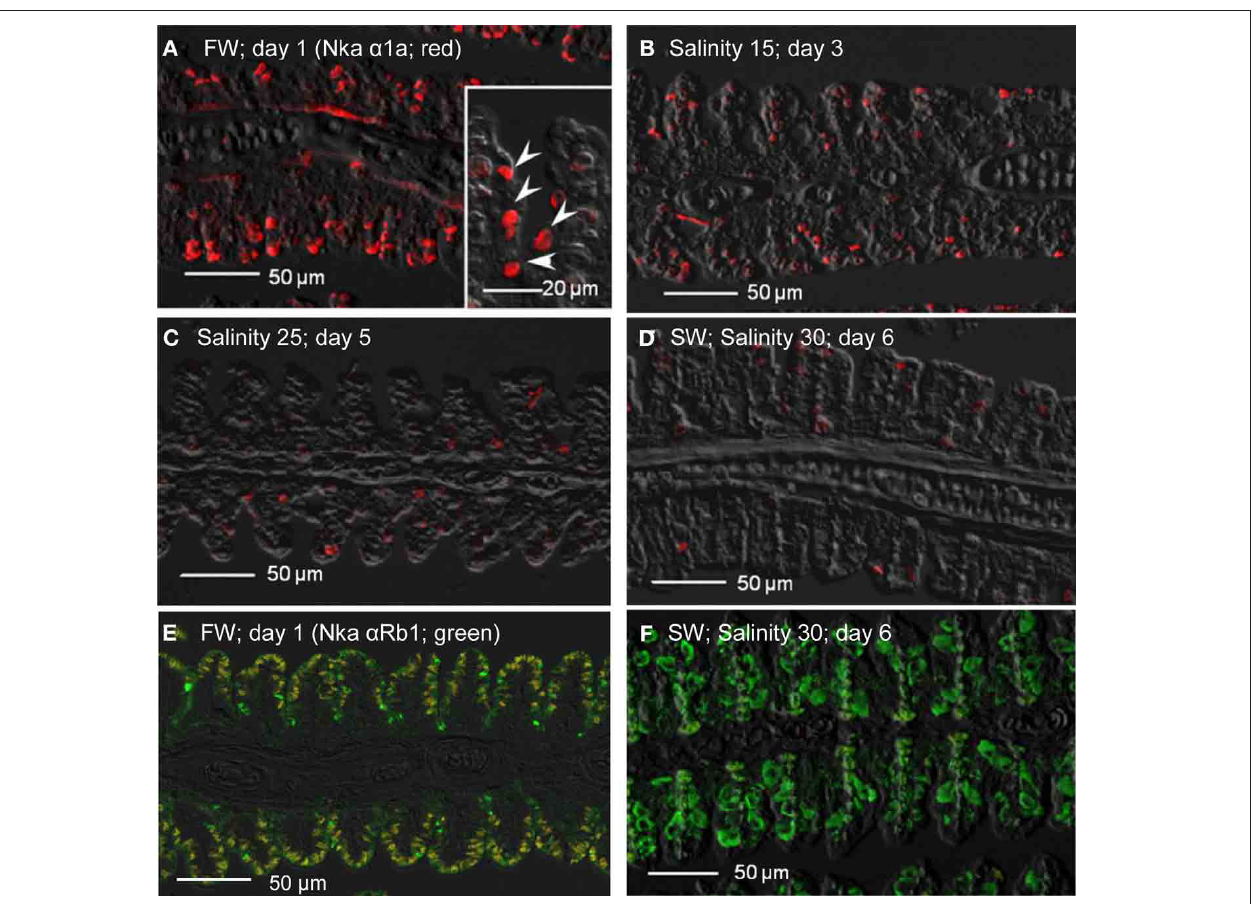
FIGURE 11 | Immunofluorescent localization of Na + /K + -ATPase α 1a (Nka α 1a; freshwater isoform; red) in the gills of Anabas testudineus kept in (A) freshwater on day 1 (FW; control), or after 24h of exposure to (B) salinity 15 on day 3, (C) salinity 25 on day 5, or (D) salinity 30 (seawater) on day 6 during a progressive acclimation from freshwater to seawater. Double immunofluorescence staining with anti-Nka α 1a (red) and anti-NKA α Rb1 (green) antibodies was performed on gills of fish kept in (E) freshwater on day 1, or (F) salinity 30 (seawater) on